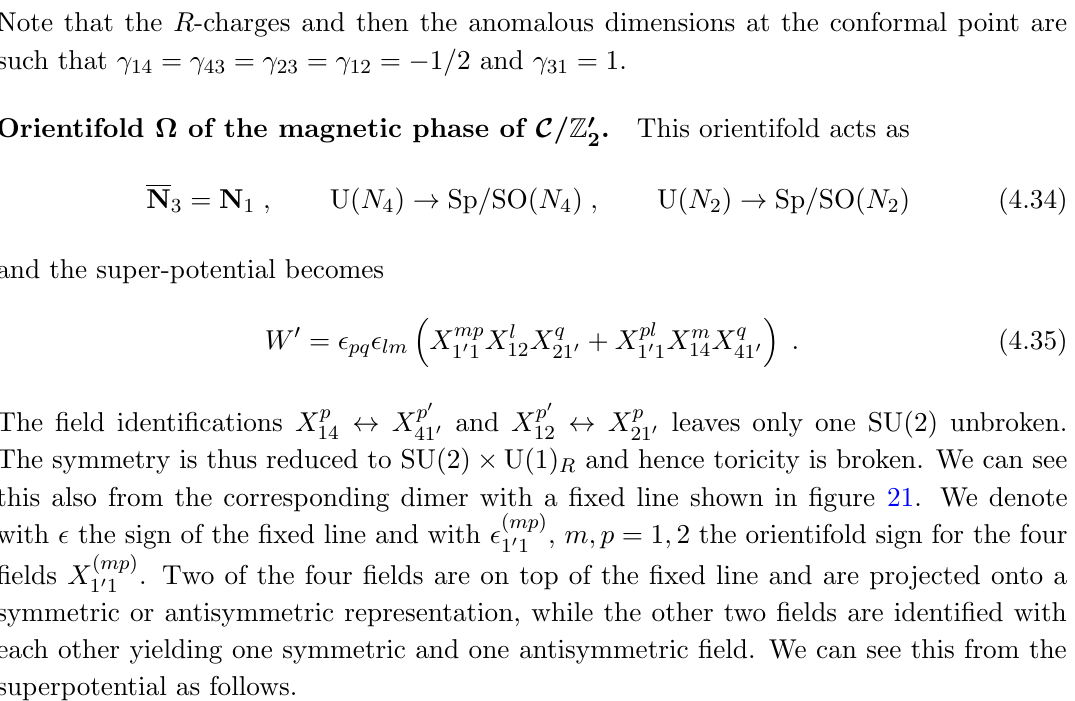
Figure 21. The orientifold involution (cid:10) of the magnetic C = Z 0 and the dimer on the center, while the toric diagram on the